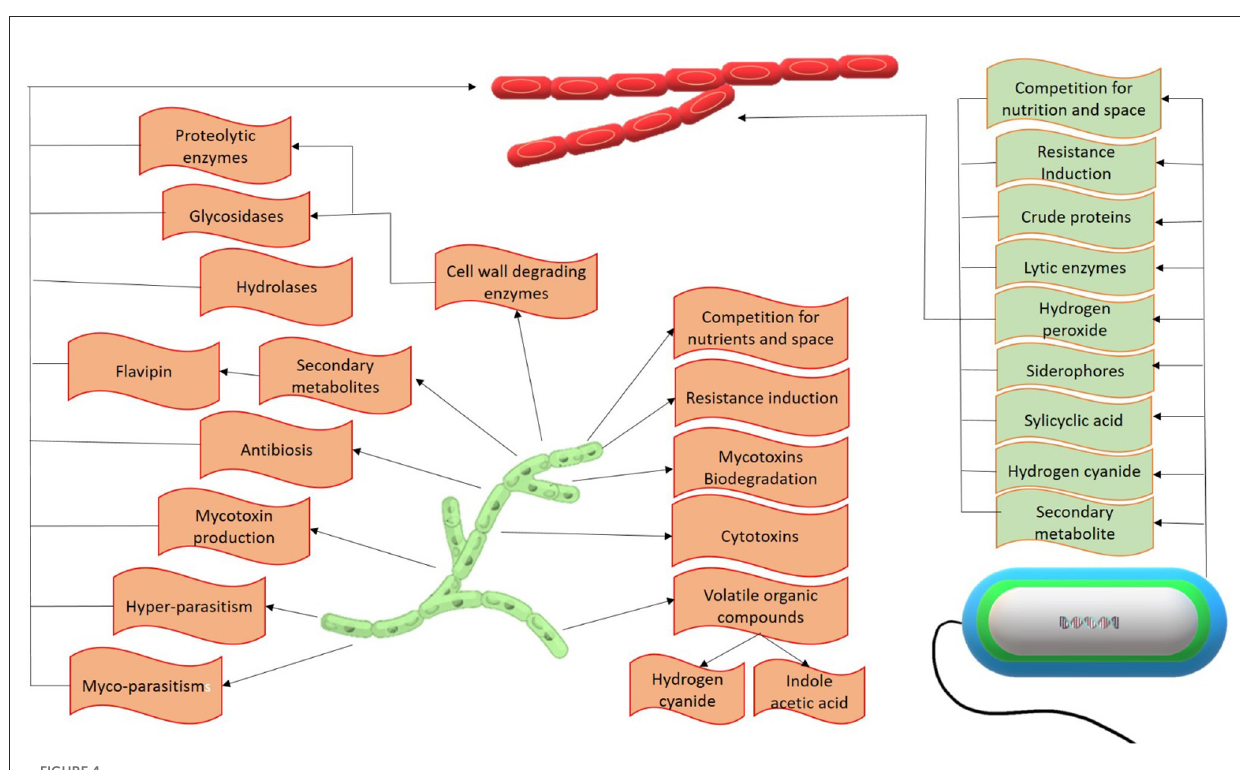
FIGURE4 Antifungal mechanism of biocontrol agents against F. fujikuroi.